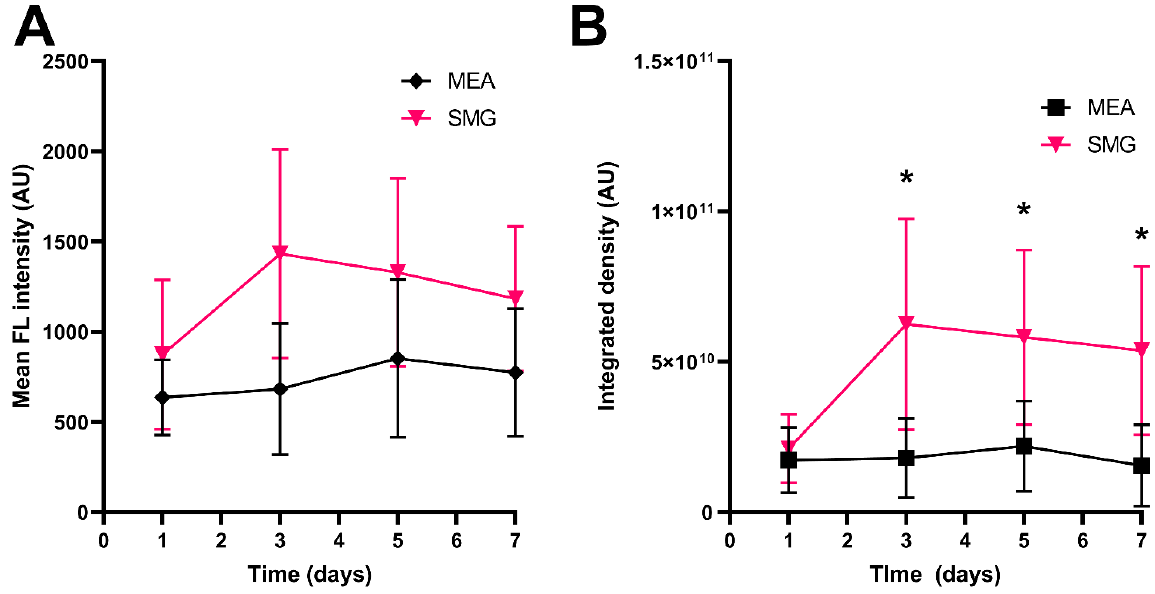
Figure 7. Expression of EGFP protein following GET of the reporter plasmid pEGFP-N1 coding for EGFP in mouse skin. ( A ) Mean fluorescence intensity of EGFP in the transfected skin after GET